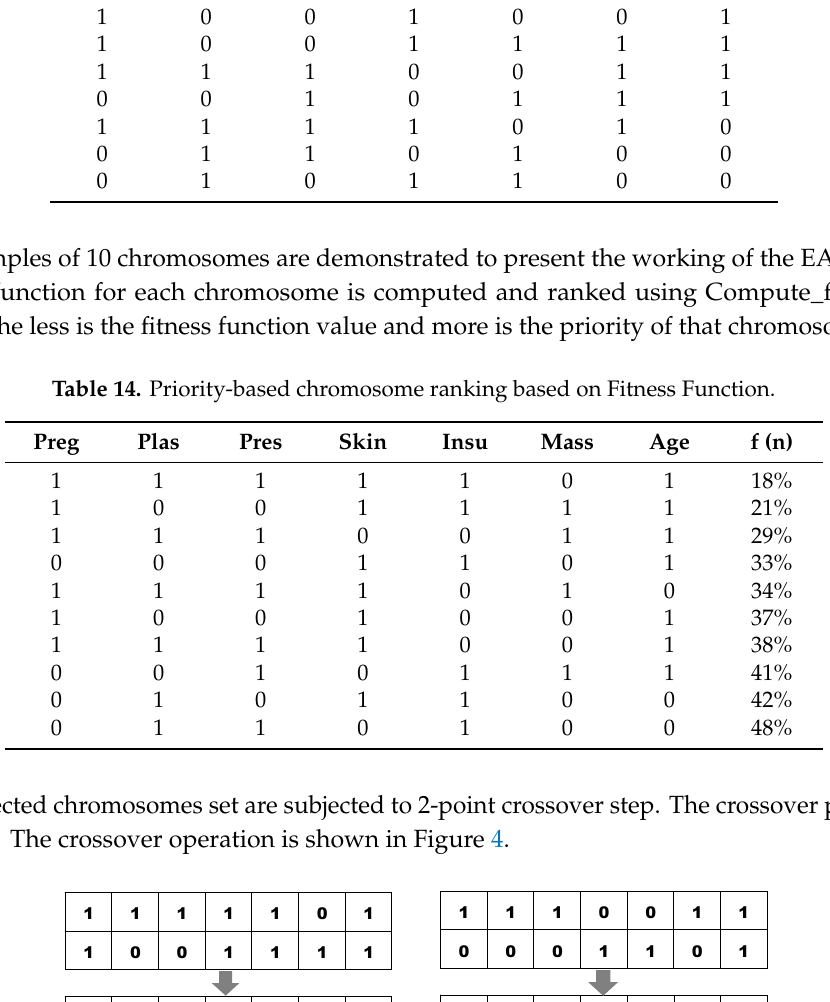
Table 14. Priority-based chromosome ranking based on Fitness Function.